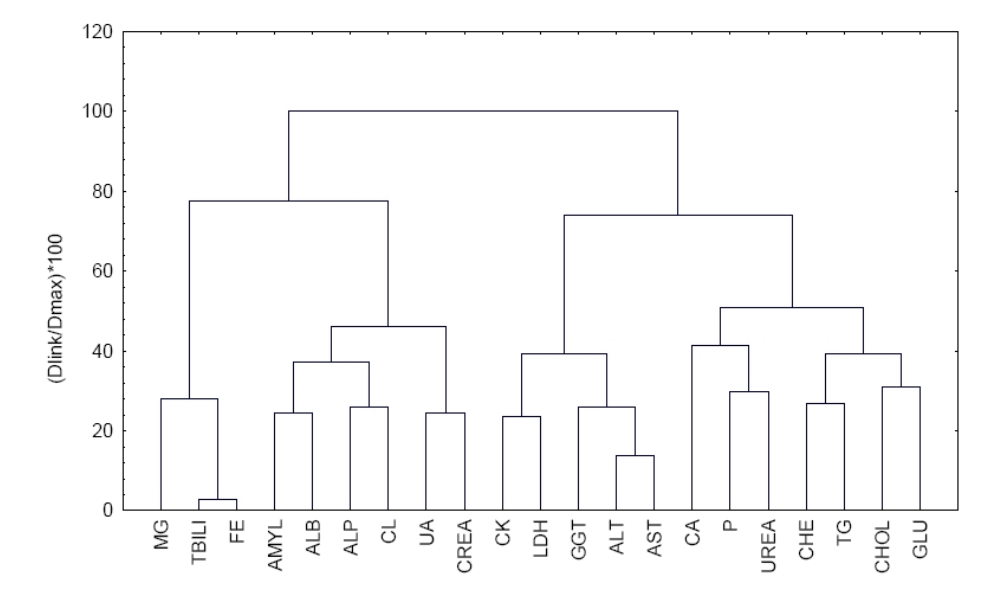
Fig. 2 Hierarchical dendrogram for 21 clinical parameters of healthy male individuals ( N =